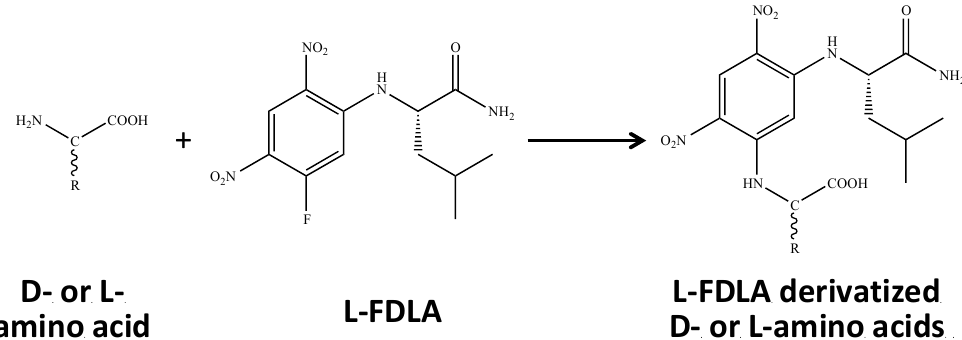
Figure 1. Scheme of derivatization for amino acid enantiomers by N α -(5-Fluoro-2,4-dinitrophenyl)- L -leucinamide ( L -FDLA). L -FDLA-derivatized amino acids become diastereomeric and can be separated by a conventional reversed-phase high-performance liquid chromatography (HPLC) column.